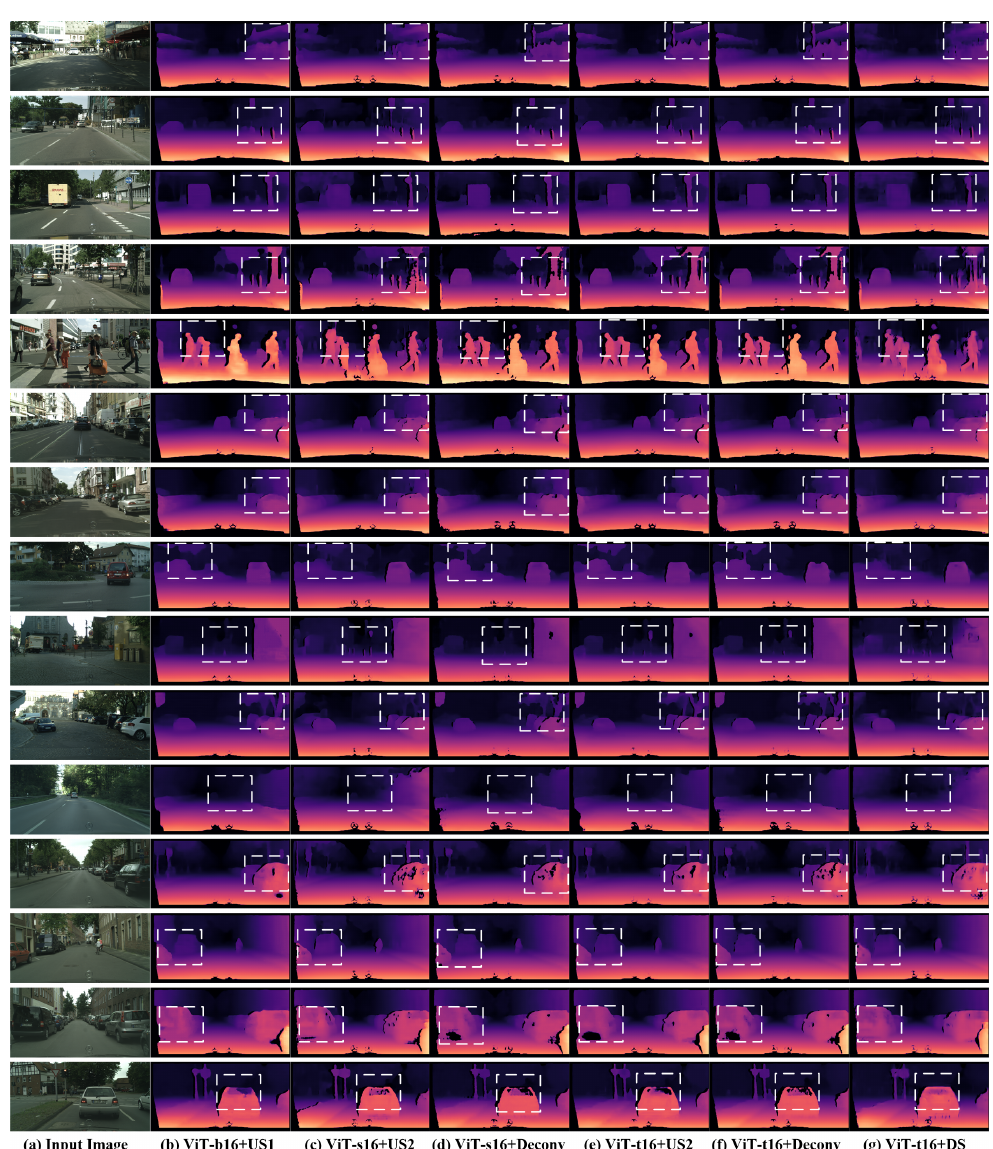
Figure 4. Sample results obtained from the proposed architectures on Cityscape validation-set: ( a ) the input image, ( b – g ) are the depth estimation results obtained from the architecture mentioned below the column, ( b ) ViT-b16 encoder and US1 decoder, ( c ) ViT-s16 encoder and US2 decoder, ( d ) ViT-s16 encoder and the Deconv decoder, ( e ) ViT-t16 encoder and US2 decoder, ( f ) ViT-t16 encoder and the Deconv decoder, and ( g ) ViT-t16 encoder and (depth-to-space) DS decoder. The regions inside the dashed white boxes include slightly obvious differences between the results of the proposed architectures on the same